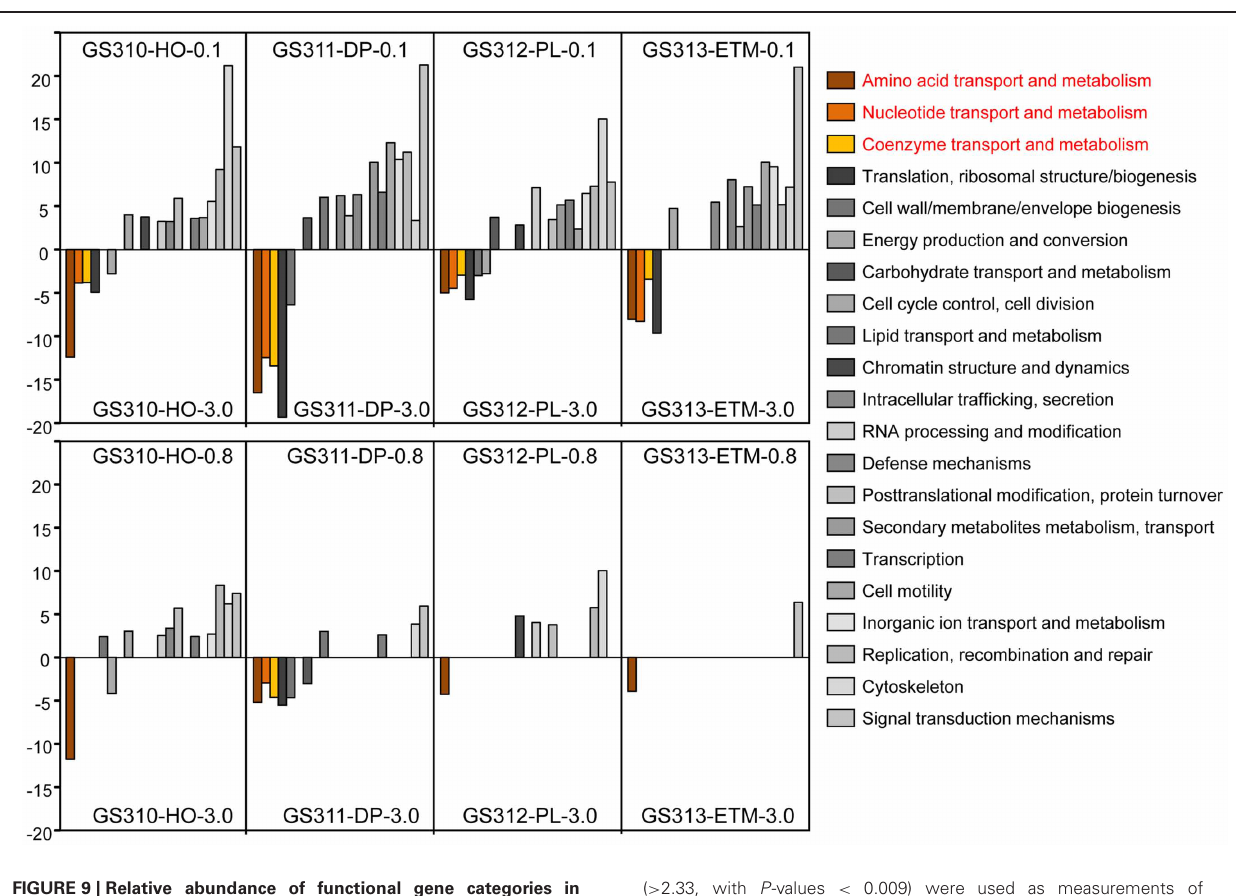
FIGURE 9 | Relative abundance of functional gene categories in the metagenomes expressed as D-rank values (bar graphs) calculated for 0.1- µ m (upper panel) or 0.8- µ m (lower panel) size fraction from each habitat compared to the corresponding 3- µ m size fraction. For each comparison, only significant D-ranks